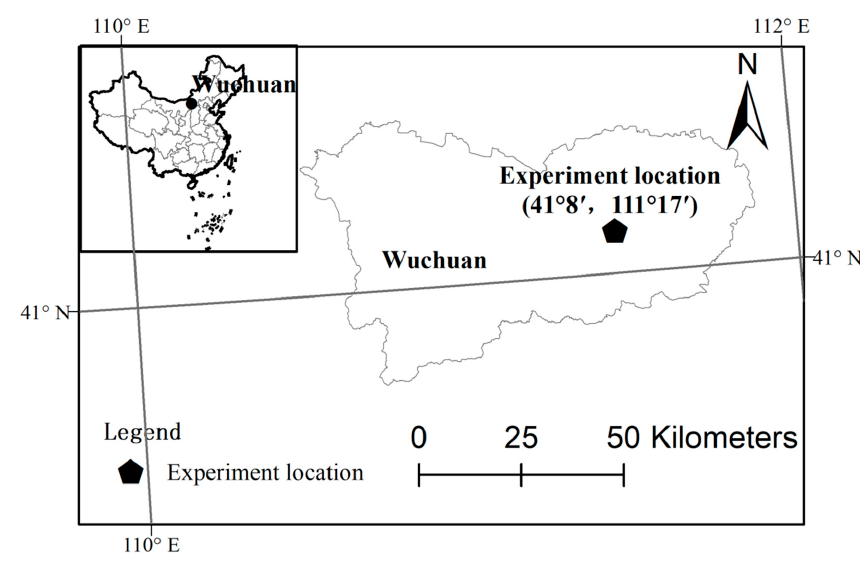
Figure 1. Study region.